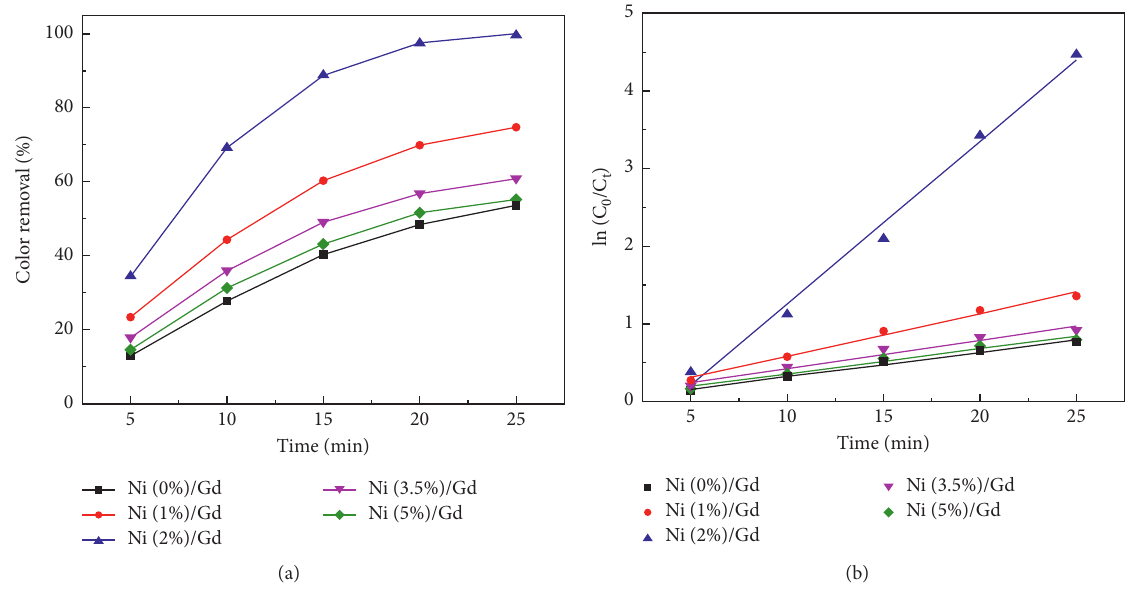
Figure 7: Electrochemical decolorization performance at Ti/SnO 2 -Sb-Ni/Gd electrodes modified with various Ni contents. (a) Decol- orization efficiency. (b) Kinetic analysis of the curves (RhB concentration: 20mg · L − 1 ; current density: 10mA · cm − 2 ; supporting electrolyte: 0.1mol · L − 1 Na 2 SO 4 ; 25 ° C). Table 2: Kinetic parameters of 20 mg · L − 1 RhB in electrochemical processes by Ti/SnO 2 -Sb-Ni/Gd electrodes modified with various Ni